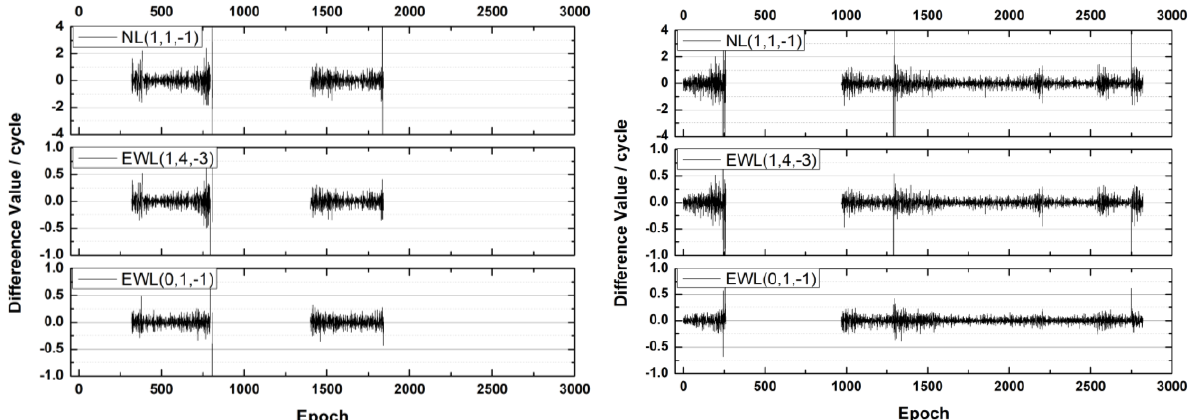
Figure 3. Combination ambiguity difference of satellite C34 and C40 between adjacent epoch for BDS-3 triple frequency